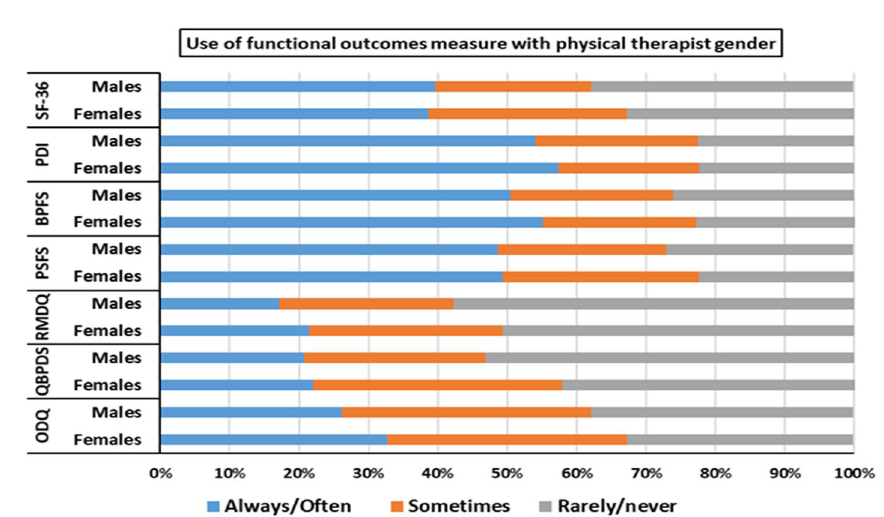
Fig. 1 The use of functional outcome measure with physical therapist